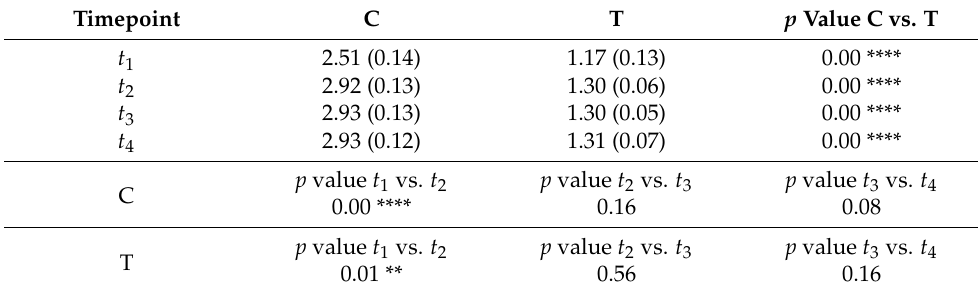
Table 2. Mean (SD) LPAI scores at t 1 , t 2 , t 3 , t 4 . SD = standard deviation; LPAI = lingual plaque